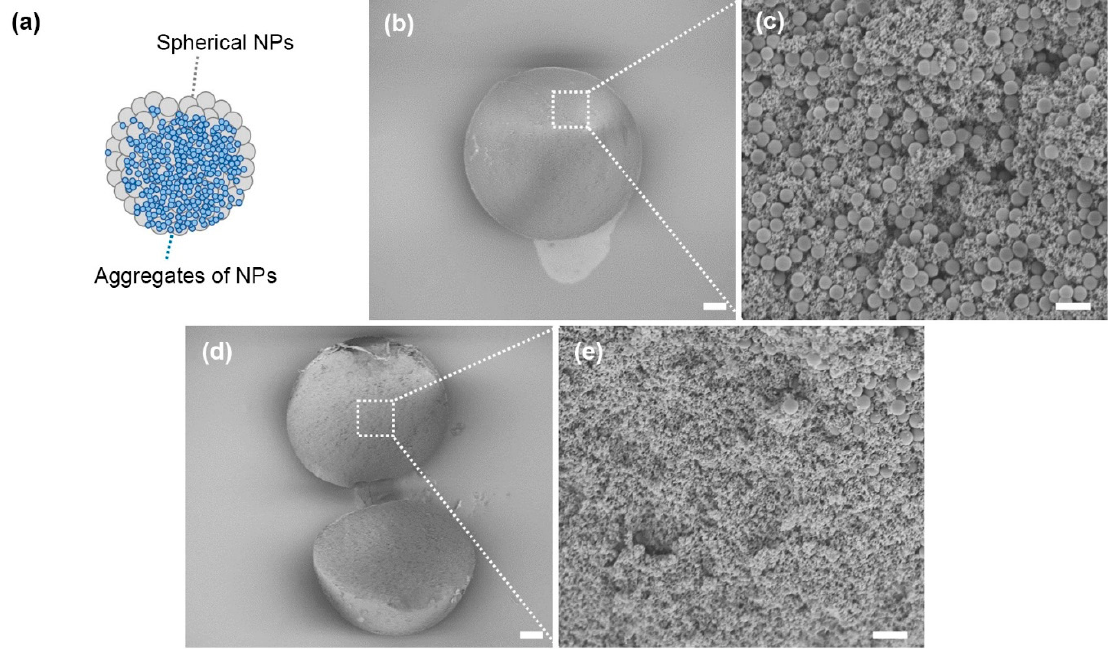
Figure 8. Core/shell supraparticle by dispersity effect. ( a ) A schematic of the bi-composite supraparticle with aggregates of NPs/spherical NPs. ( b , c ) SEM images of the surface of the bi-composite supraparticle. ( e ) Cross-sectional SEM image of the bi-composite supraparticle, characterized after breaking the supraparticle. ( d , e ) High magnification SEM images of the inner-structure (indicated as boxes in image ( e ) of the supraparticle; ( d ) the boundary and ( e ) the core of core and shell, respectively. The scales are 100 μ m for ( b , e ) and 1 μ m for ( c , d ).